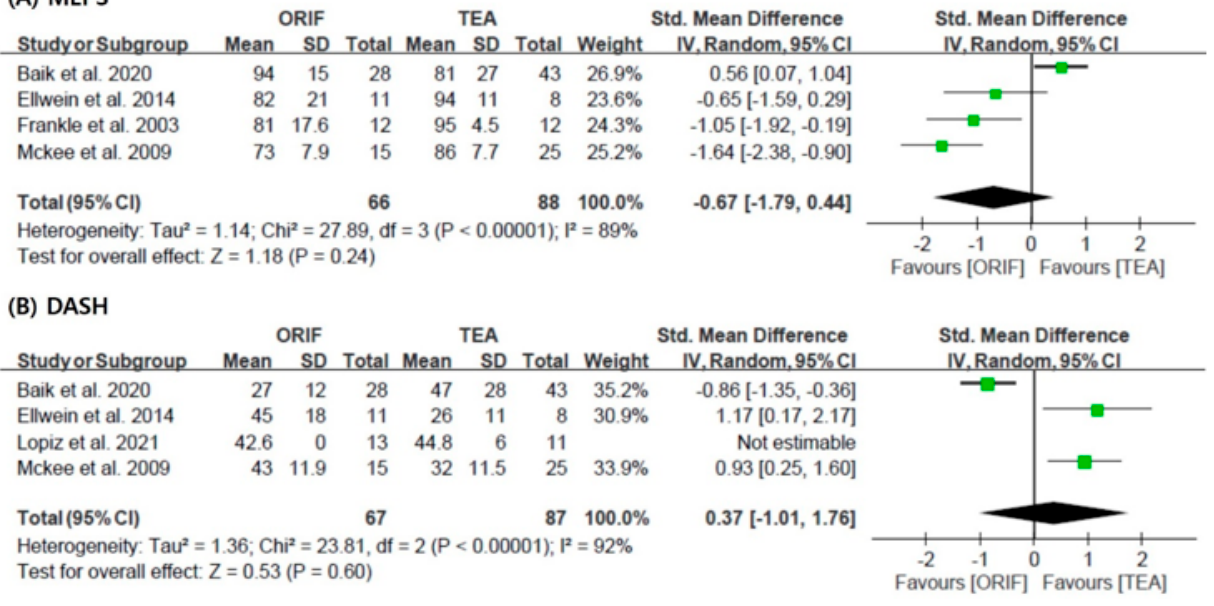
Figure 2. Results of the meta-analysis with respect to the functional scores: ( A ) MEPS, and ( B ) DASH [5,10,21,24,27]. MEPS: Mayo Elbow Performance score; DASH: Disabilities of the Arm, Shoulder, and Hand; ORIF: open reduction and internal fixation; TEA: total elbow arthroplasty; SD: standard